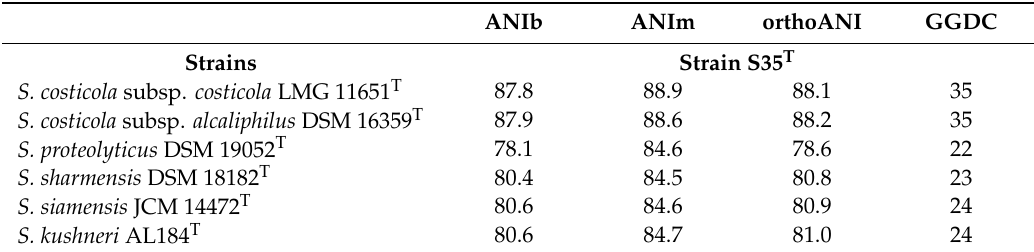
Table 1. Average nucleotide identity (ANI), calculated using three different methods (ANIb, ANIm, and orthoANI) and in silico DNA–DNA hybridization (GDDC) values (%) for strain S35 T and the type strains of the species and subspecies of the genus Salinivibrio .